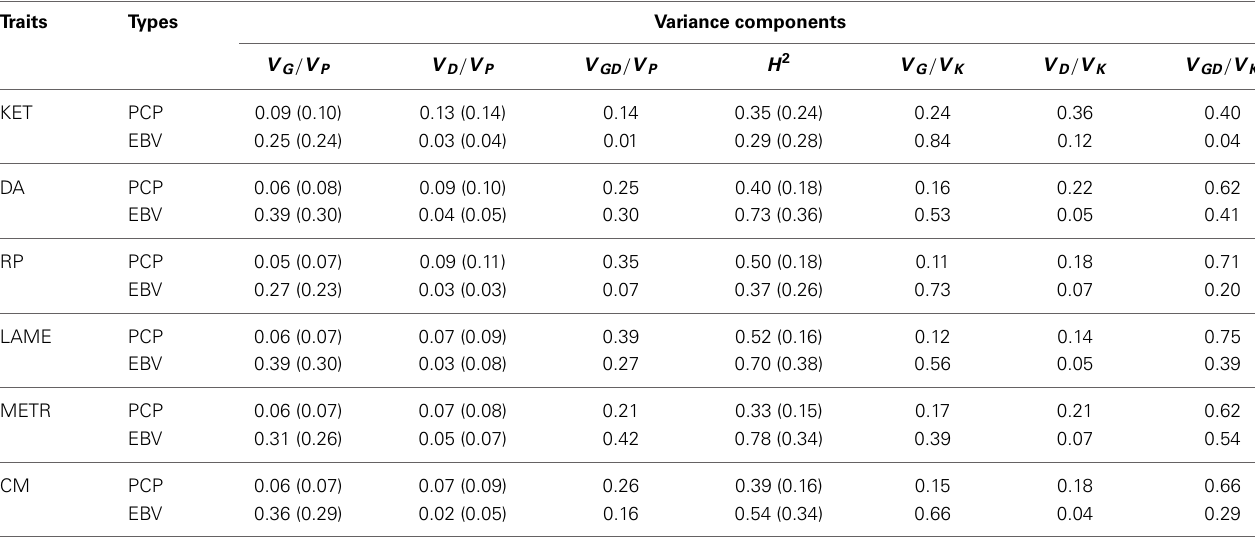
The epistatic kernel was created from the Hadamard product of additive and dominance kernels. Pre-corrected phenotype (PCP) and estimated breeding value (EBV) were used as phenotypes. V G , V D , V GD , and V K represent marked additive ( σ 2 G ), marked dominance ( σ 2 D ), marked additive by dominance ( σ 2 GD ), and total marked genetic variance ( ˜ σ 2 K = σ 2 G + σ 2 D + σ 2 GD ), respectively, H 2 is estimated marked broad sense heritability. Values in parentheses are estimated weights when kernels were fitted